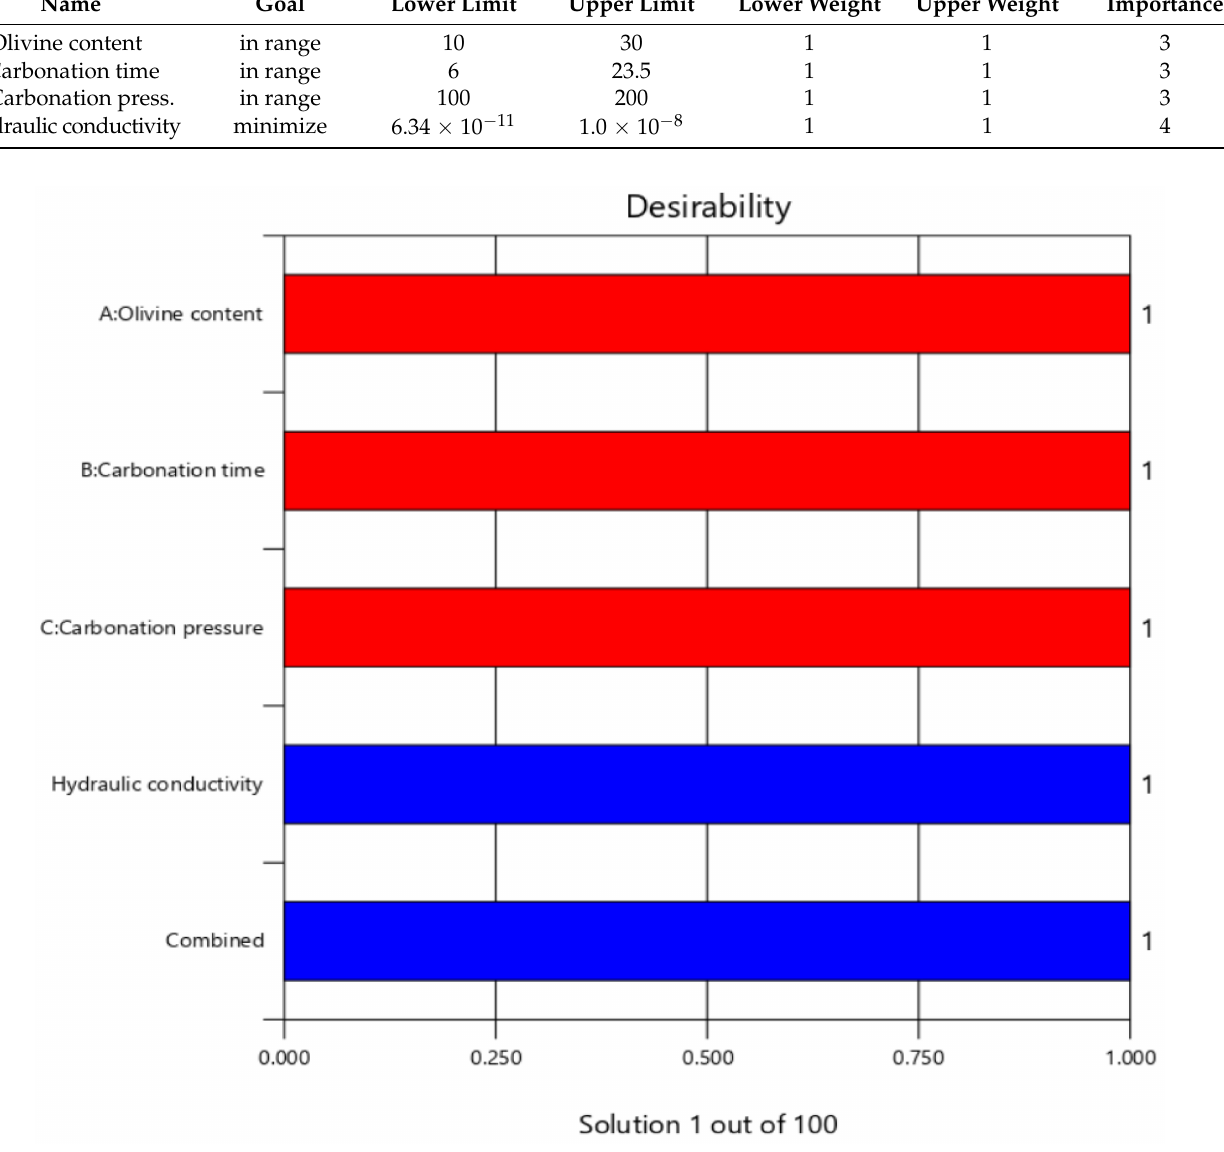
Figure 12. Bar graph representing individual desirability of all responses ( d i) in correspondence with combined desirability